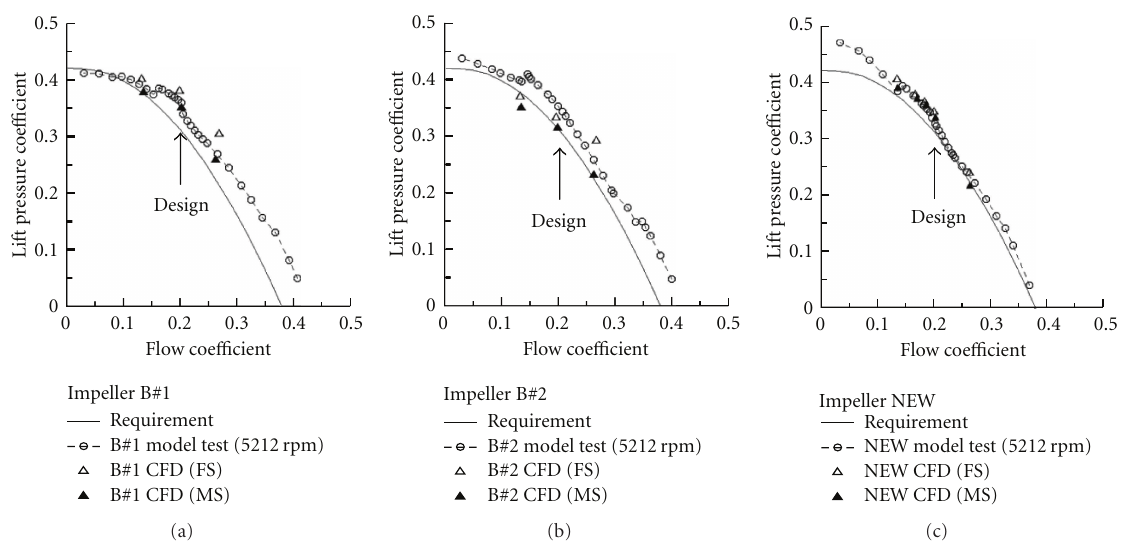
Figure 21: Measured lift pressure coe ffi cient compared with the requirement and CFD predictions for the B#1, B#2, and NEW impellers.